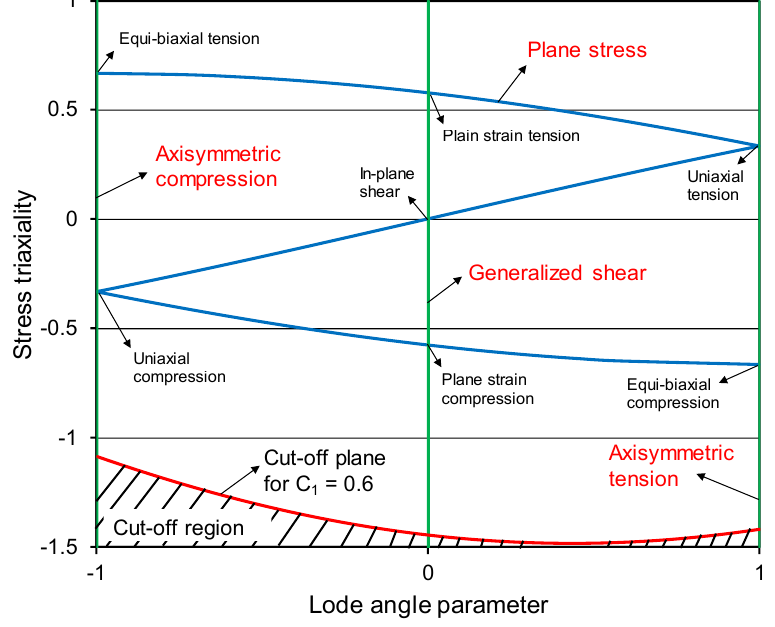
Figure 7. Shape of the cut-off region of the proposed fracture model for C 1 =